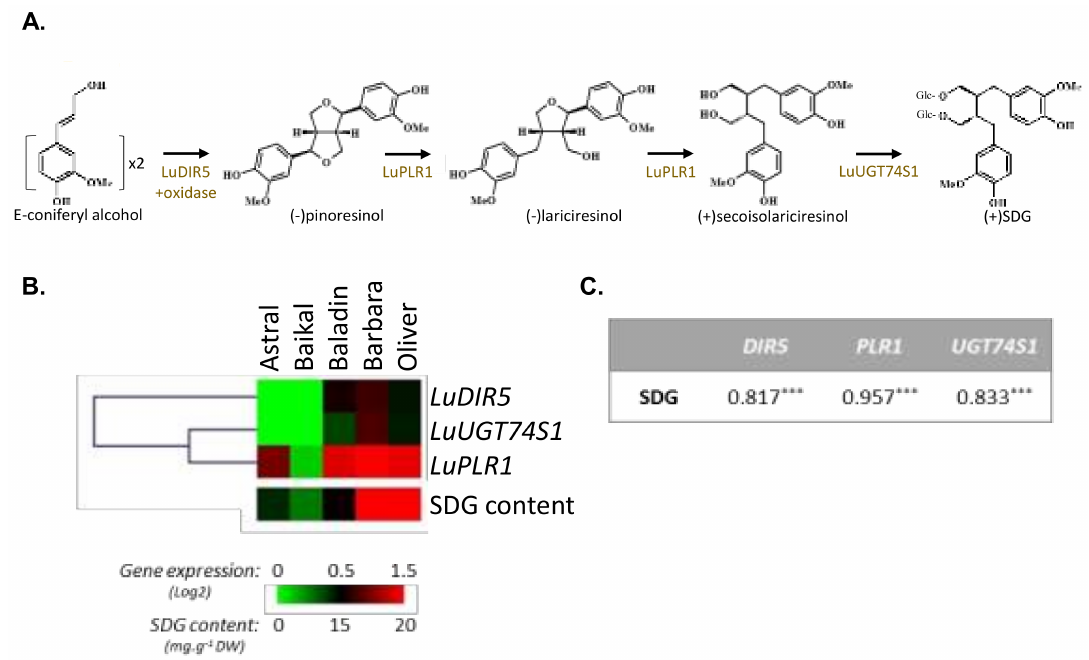
Figure 2. Expression profile of flax lignan biosynthetic gene and SDG accumulation in five flaxseed cultivars. ( A ) Biosynthetic pathway leading to the formation of (+)-SDG in flaxseed. ( B ) Expression of LuDIR5 , LuPLR1 , and LuUGT74S1 determined by RT-qPCR (normalized with CYC and ETIF5A reference genes) visualized using MeV4 ( n = 3) and SDG content measured by HPLC and visualized using MeV4 ( n = 3). ( C ) Pearson correlation matrix between (+)-SDG accumulation and the corresponding biosynthetic gene expression. Significance level: * p < 0.05; ** p < 0.01; *** p <